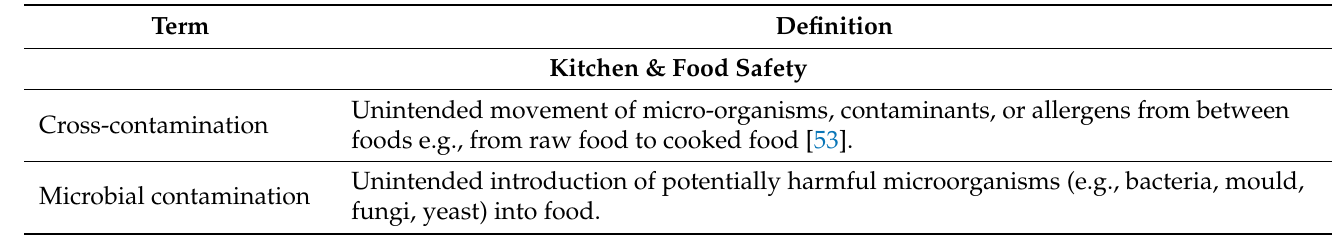
Table A1. Glossary of key terms within the Cook-Ed TM